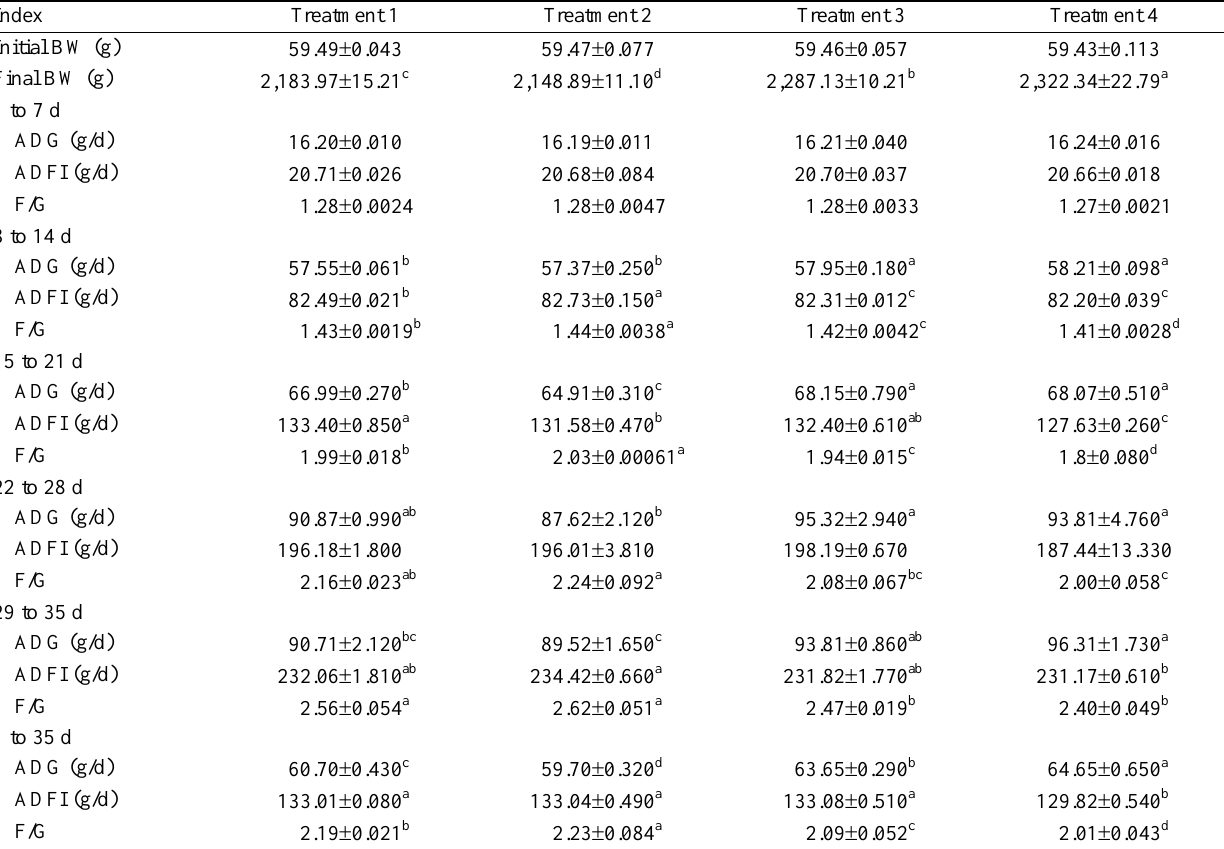
Table 3. The effect of the enzyme complex on the growth performance in